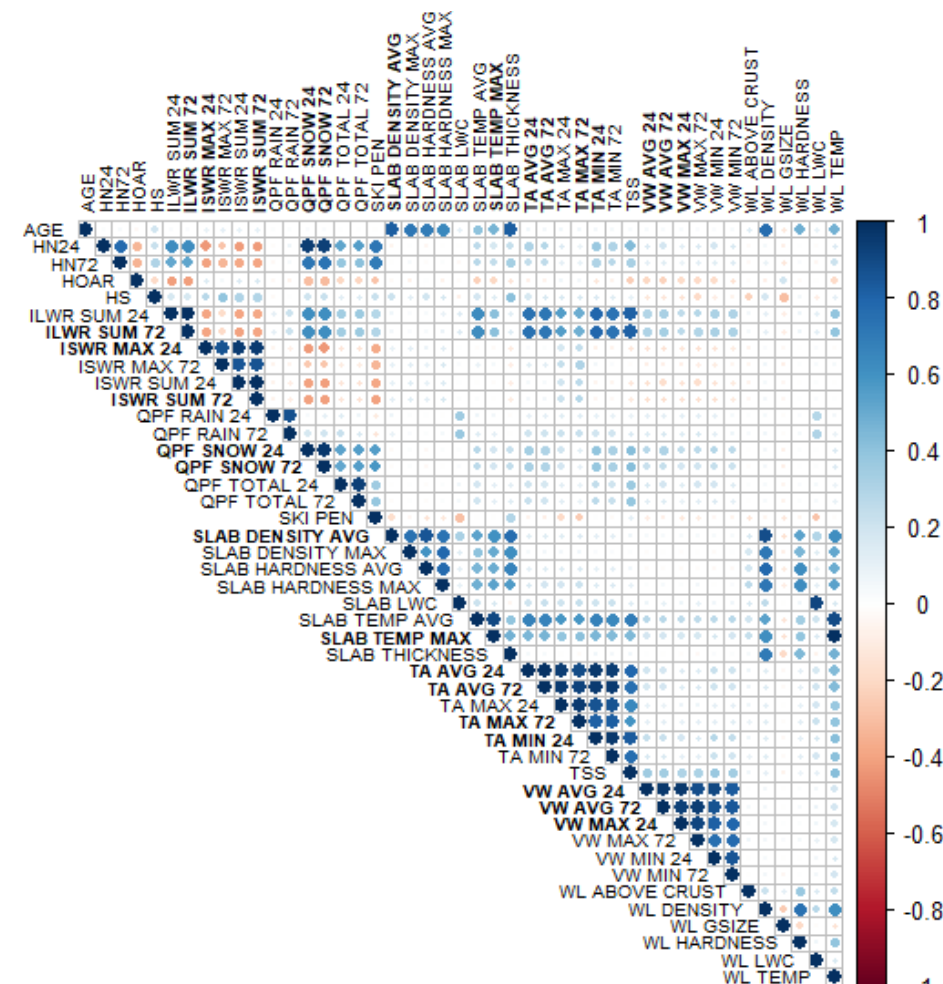
Figure B2. Correlation matrix for weather and snowpack variables used in decision trees for persistent avalanche problems. Variables in bold were removed due to high correlation with other variables. Variable names are described in Tables 2, 3, and